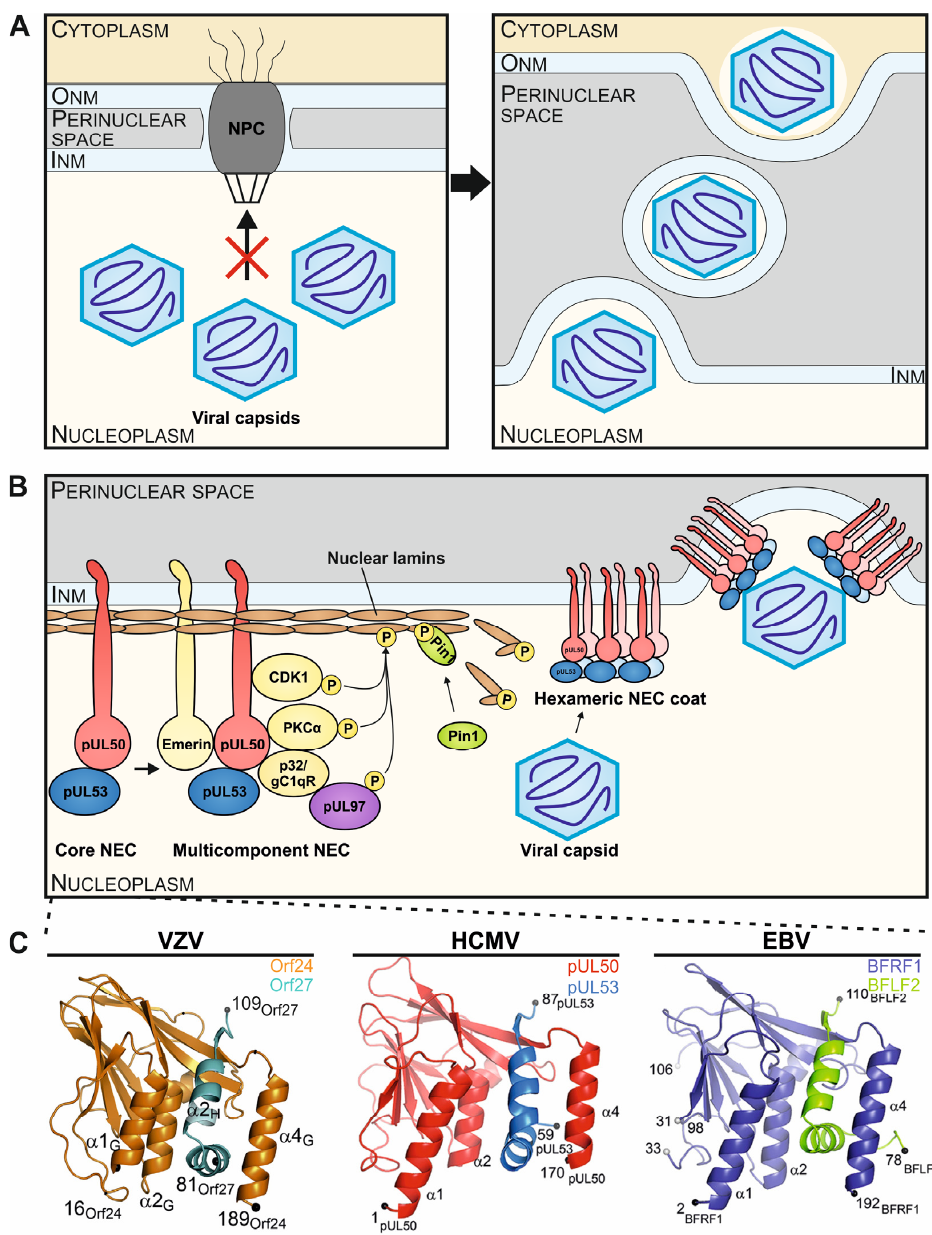
Figure 1. Illustration of the principle and multifunctional properties of the herpesviral nuclear egress complex (NEC) through the formation of core and multicomponent NEC arrangements. ( A ) Herpesviral capsids, assembled in the nucleus of infected cells, exceed the size exclusion limits of the nuclear pore complex (NPC), so that the fine ‐ regulated process of nuclear egress evolved to enable the efficient nucleocytoplasmic transition of capsids through the nuclear envelope (INM and ONM, inner and outer nuclear membranes). ( B ) A schematic representation visualizes the stepwise formation of the HCMV ‐ specific NEC, in its heterodimeric and hexameric core versions, and the multicomponent extension, including NEC ‐ associated proteins. The core NEC, consisting of pUL50 and pUL53, recruits several cellular and viral proteins for the temporary reorganization of the nuclear lamina. A hexameric arrangement of the core NEC facilitates the docking and egress of viral capsids through the INM into the perinuclear space (refined illustrations referring to [20]). ( C ) Crystal structures of the VZV Orf24 ‐ Orf27, EBV BFRF1 ‐ BFLF2 and HCMV pUL50 ‐ pUL53 hook ‐ into ‐ groove formations in ribbon representations (refined illustrations referring to [14,18,19]).